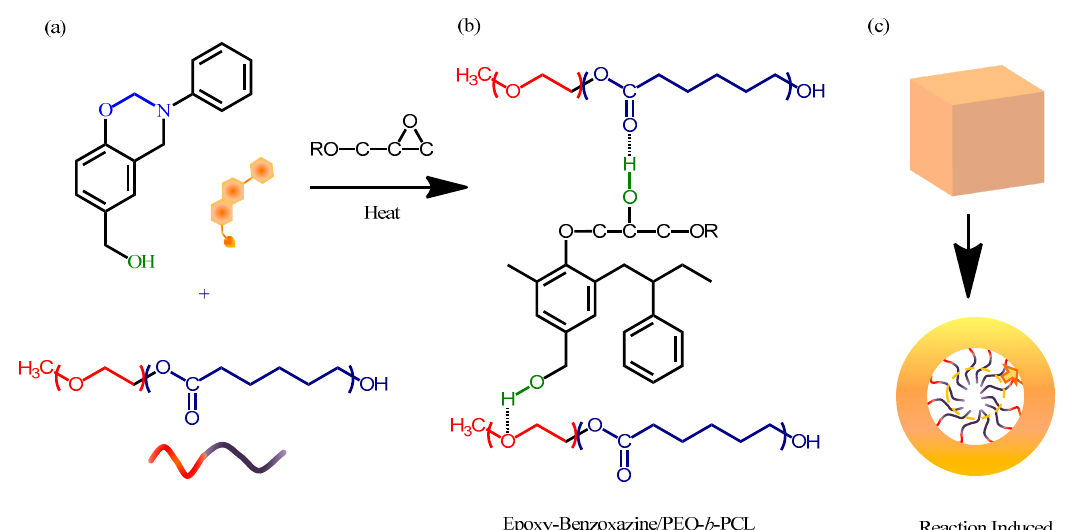
Figure 2. ( a ) Chemical structures of PA-OH and PEO- b -PCL. ( b ) Intermolecular hydrogen bonding between the OH units of the epoxy–benzoxazine (obtained after thermal curing) and the C–O–C units of the PEO segment and the C=O units of the PCL segment. ( c ) Self-assembled wormlike structures formed through reaction-induced microphase separation.